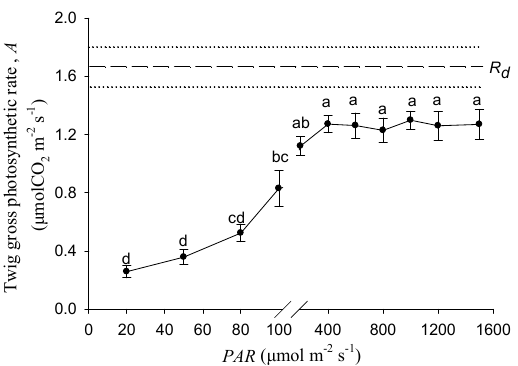
Figure 2. The responses of twig gross photosynthetic rate to different PAR . Data were mean ± SE with n = 6. The different lowercase letters indicate a significant ( p < 0.05) difference among the light intensities. R d represents the dark respiration rate, and dashed and dotted lines represent the mean and mean ± SE of R d .